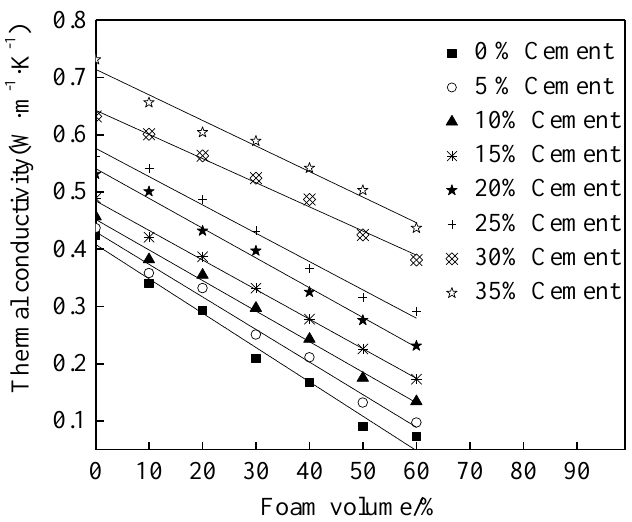
Figure 1. The relationship between the thermal conductivity and foam volume. Table 3. The fitting results of the thermal conductivity and foam volume.